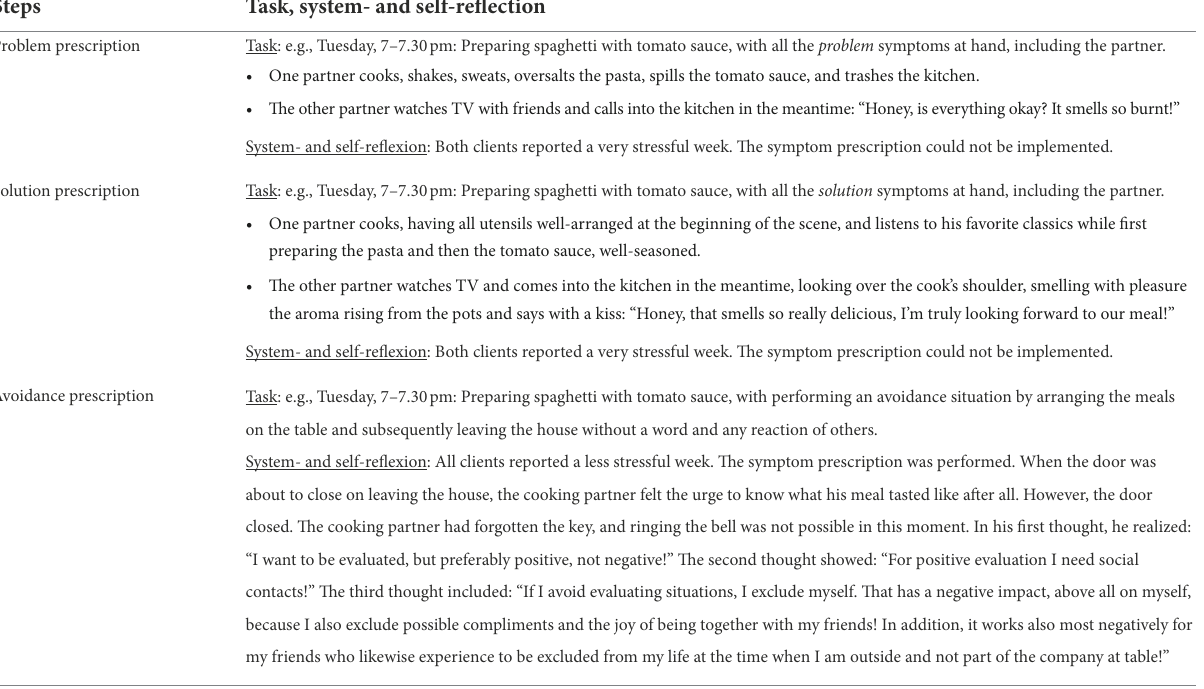
TABLE 9 Three-step approach of symptom prescription (Schweitzer et al.,